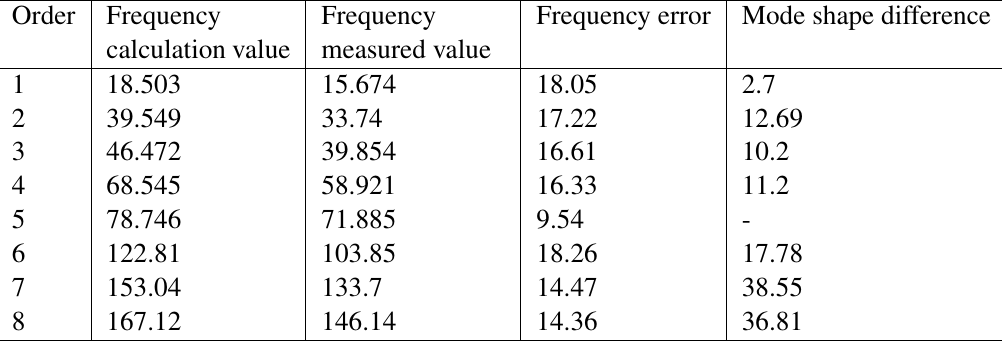
Table 1 Comparison of calculated and measured modal parameters before correction